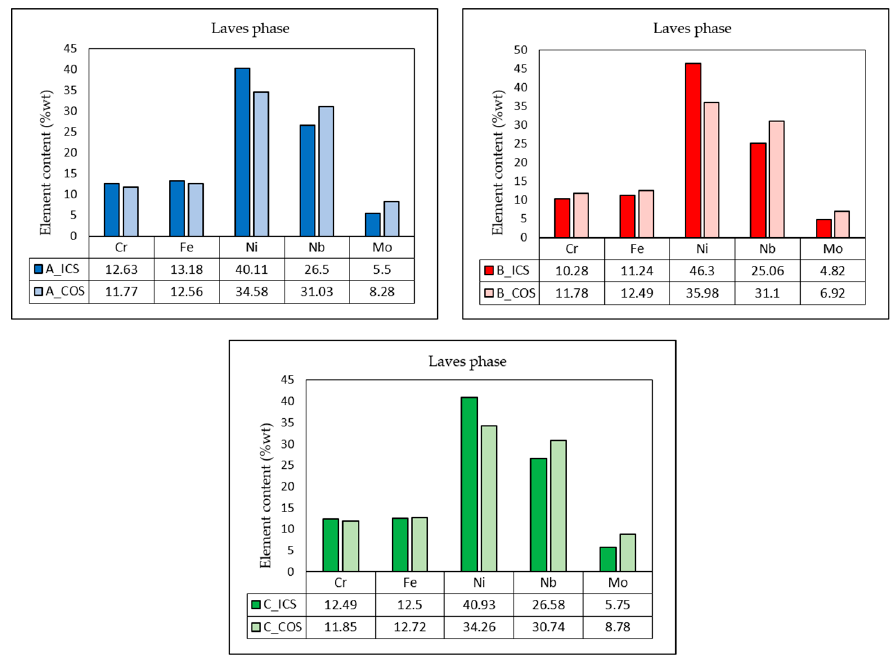
Figure 15. Comparison of Laves phase in the different deposition strategies (EDS Spot 1) .